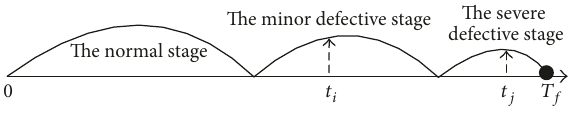
Figure 1: A three-stage failure